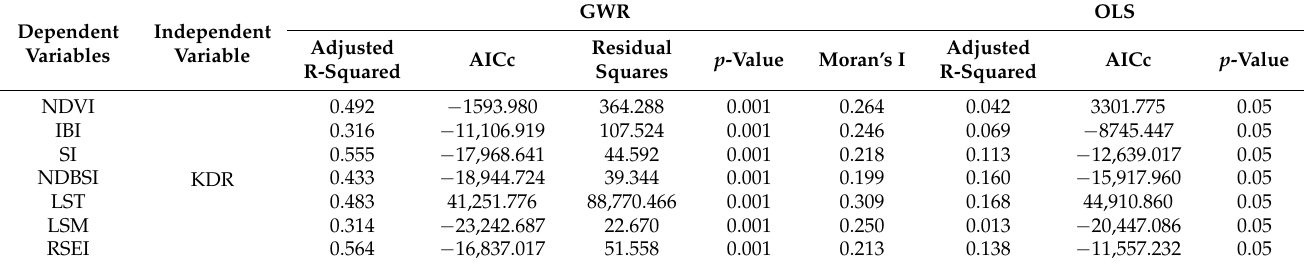
Table 2. Tests of the ordinary least squares (OLS) and the geographically weighted regression (GWR)